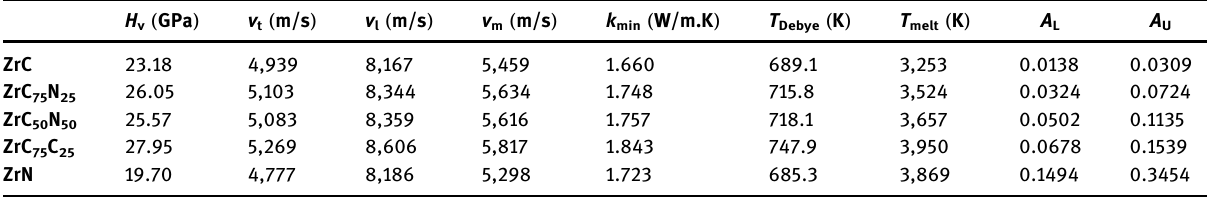
Table 3: Hardness, sound velocities, minimum thermal conductivity, melting temperature, and anisotropy indices for ZrC x N ( 1 − x ) H ( GPa ) v ( m/s v t